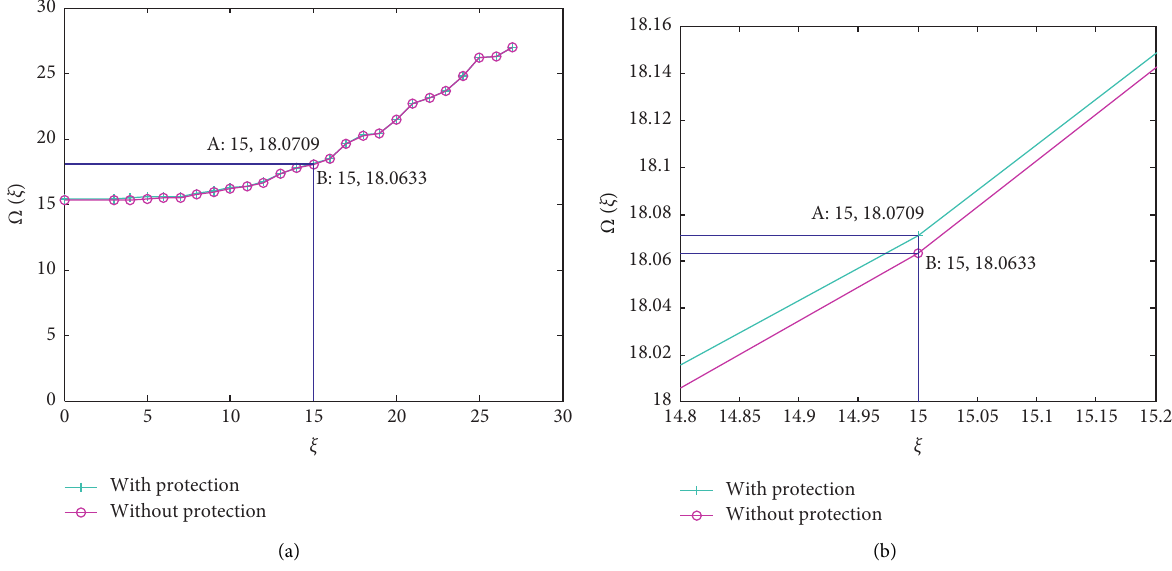
Figure 9: Conditional expected performance comparison. (a) The whole graphs. (b) The local